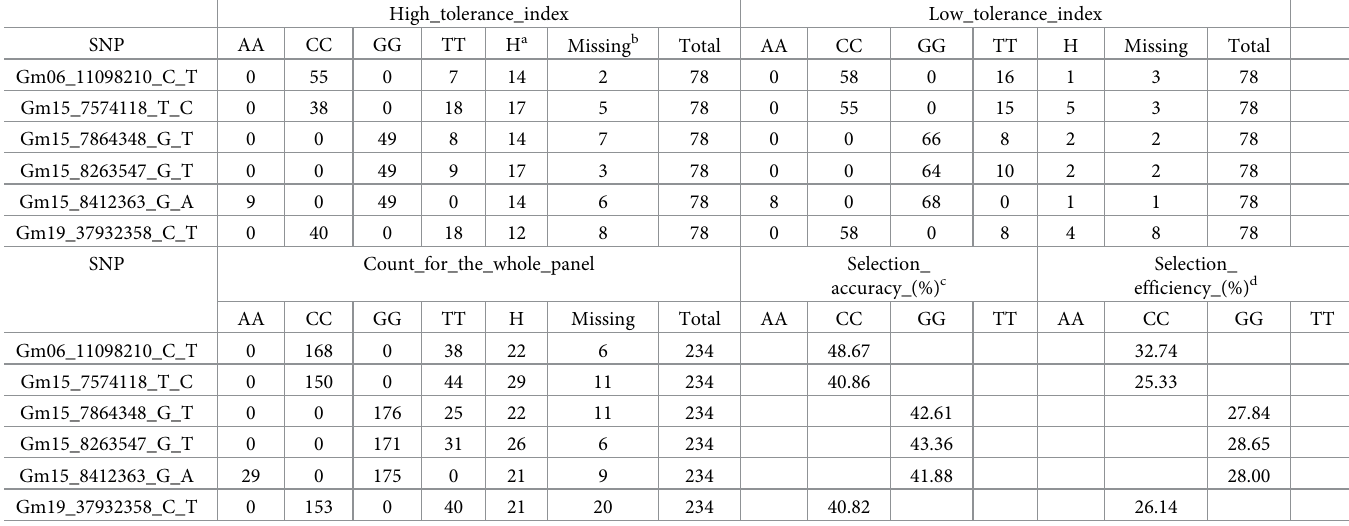
Table 5. Genotypic count for the top 78 soybean accessions with the highest tolerance index under SCN infestation, top 78 soybean accessions having the lowest tol- erance index under SCN infestation, and selection accuracy and efficiency for the SNPs associated with tolerance index based on biomass reduction under SCN